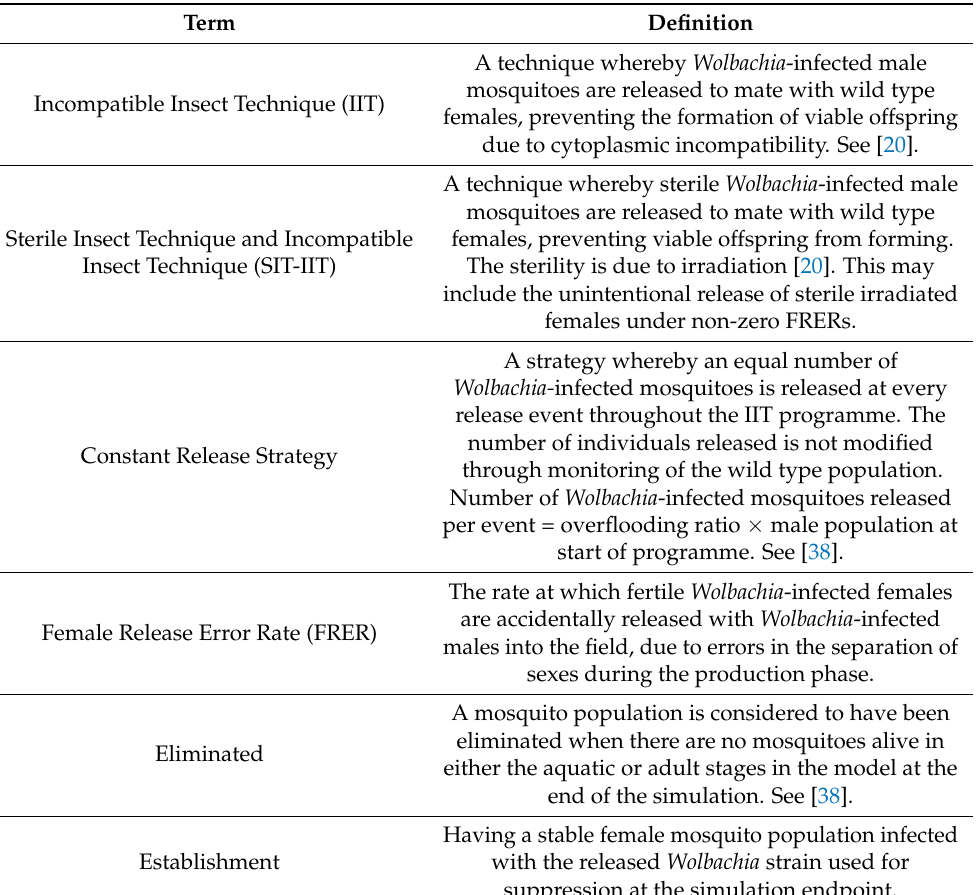
Table 1. Glossary of